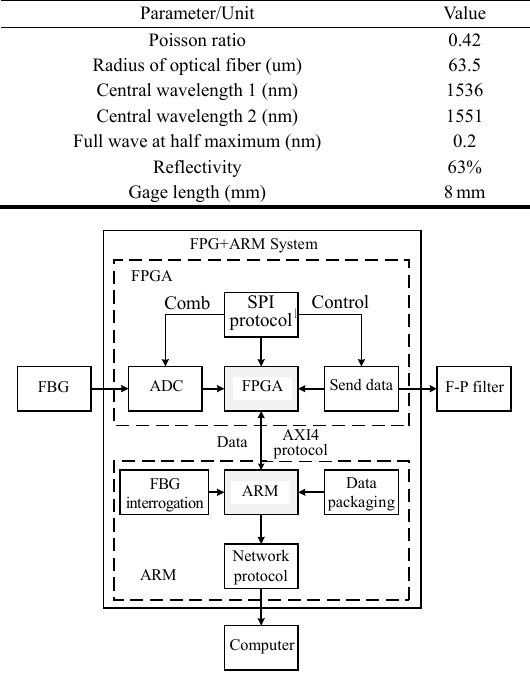
Fig. 6 Structure diagram of interrogation system.